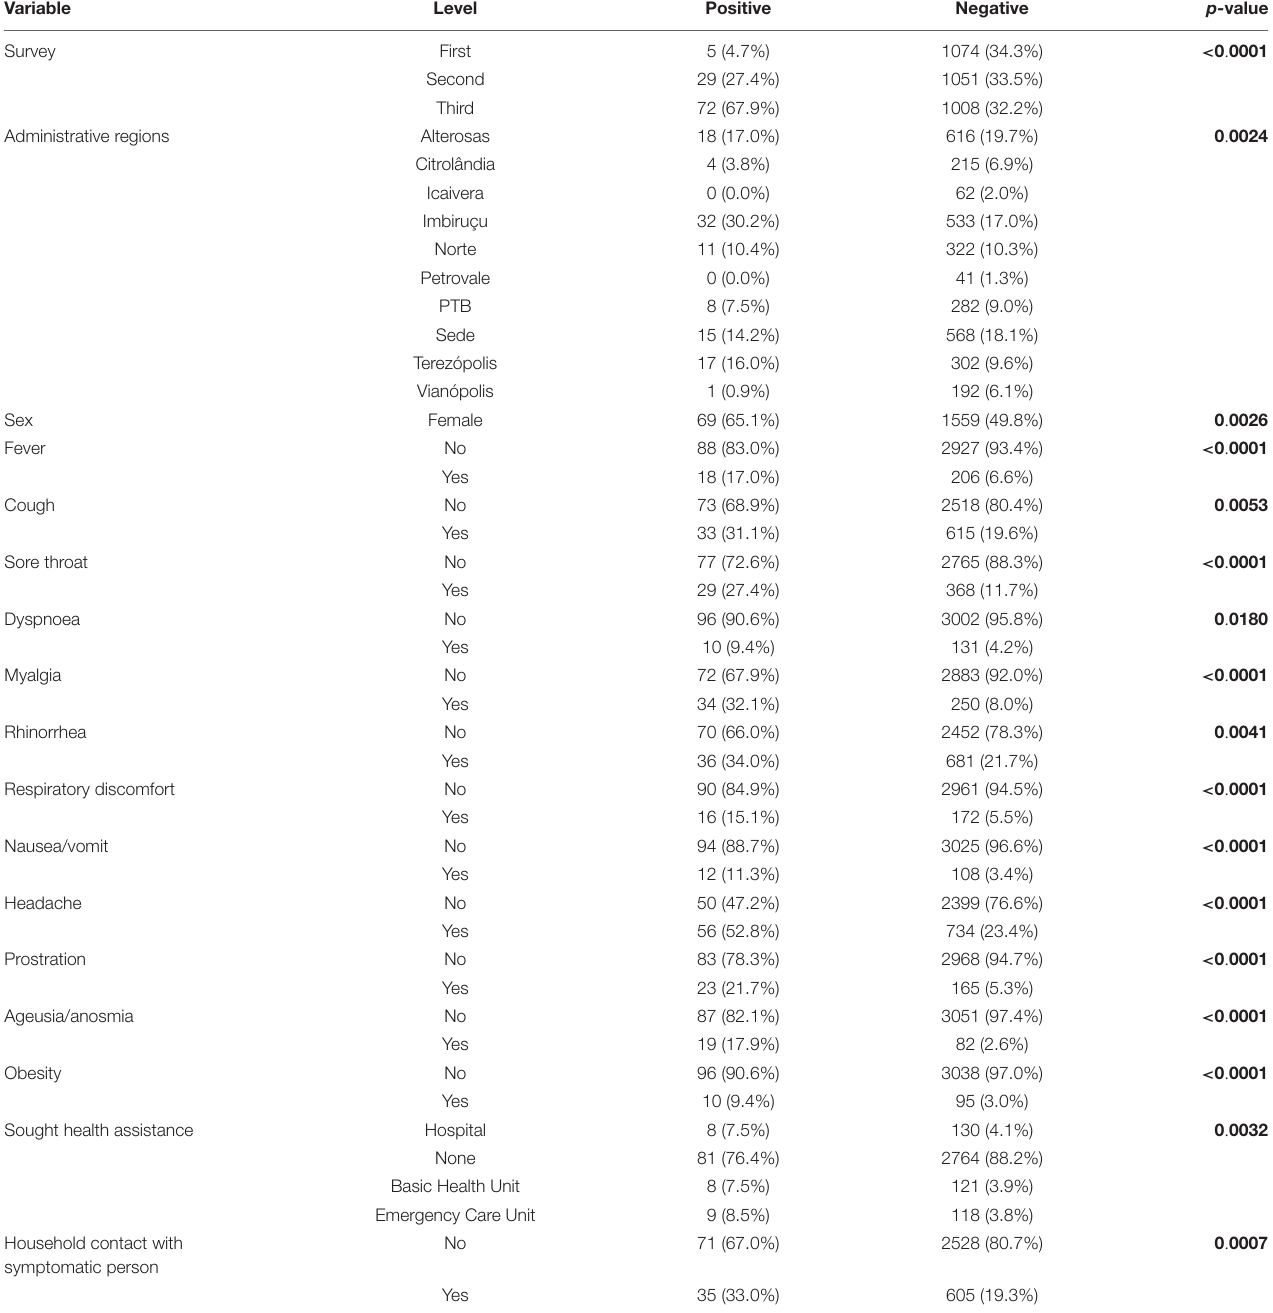
TABLE 2 | Significant clinical and epidemiological data associations with a positive test (serological or molecular).